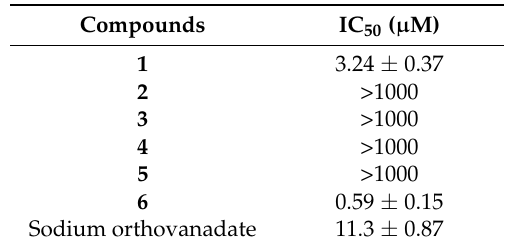
Table 2. PTP1B inhibitory activities of 1 – 6 .